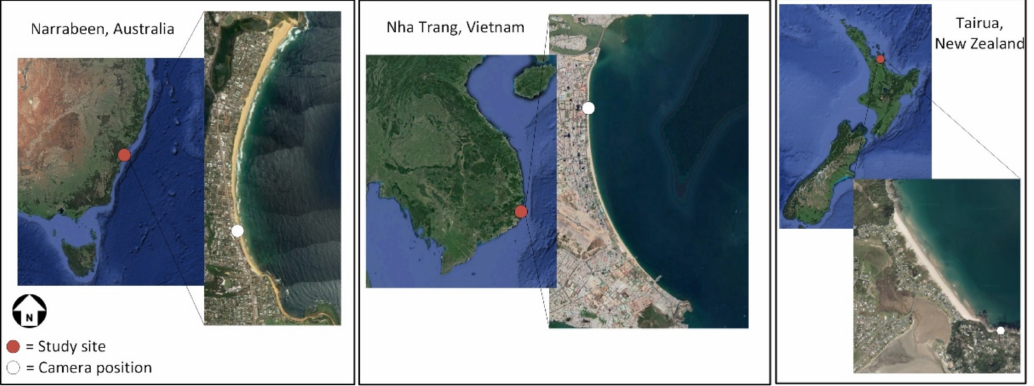
Figure 1. Overview of the model training sites and positions of the camera stations from which high-resolution shoreline data is extracted. Left: Narrabeen and Colleroy beach embayment. Middle: the Nha Trang beach in Vietnam. Right: Tairua beach in New